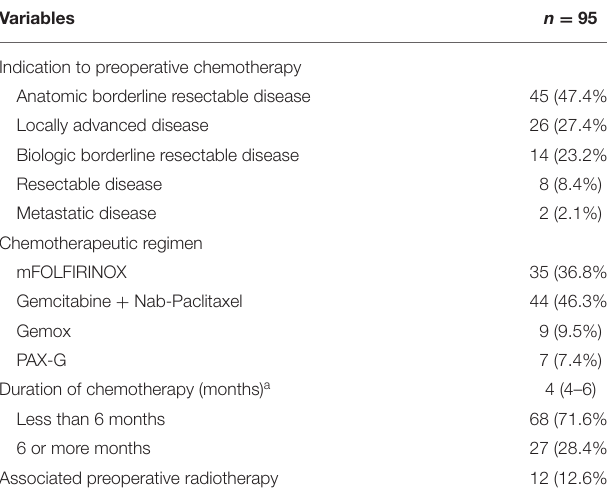
TABLE 1 | Characteristics of neoadjuvant therapy in 95 treated patients. TABLE 2 | Characteristics of the entire